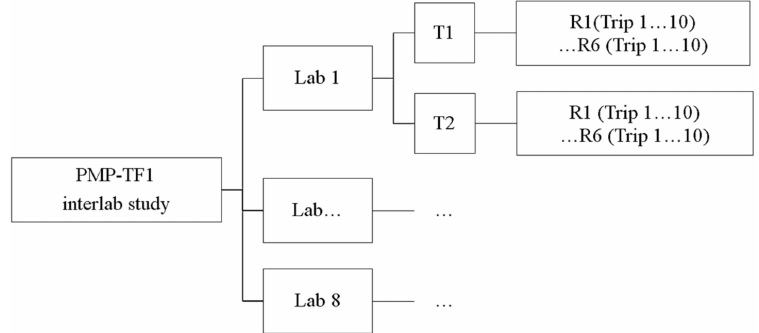
Figure 1. Schematic hierarchy of Labs (Lab 1–Lab 8), Tests (T1 and T2), Repeats (R1–R6) and Trips (Trip #1–Trip